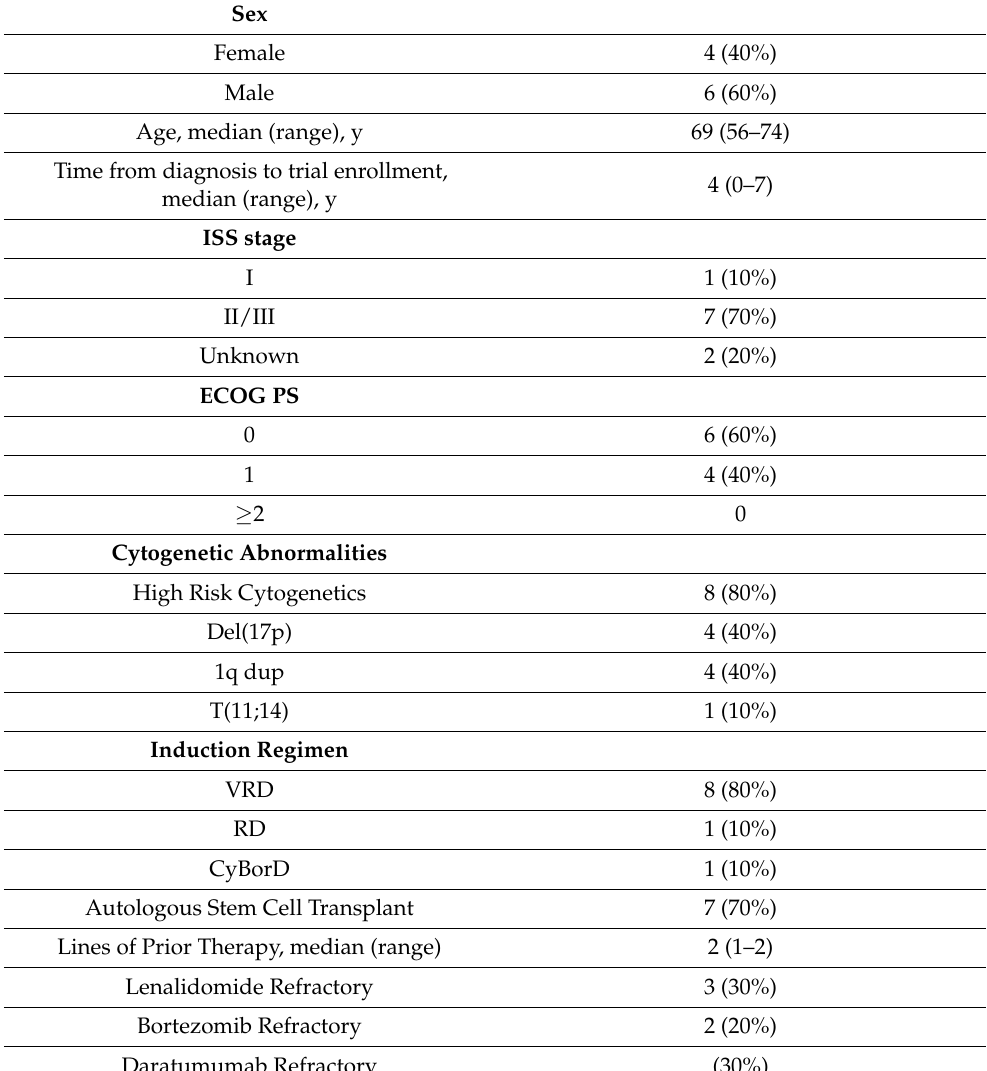
Table 1. Patient demographics and clinical characteristics ( n =